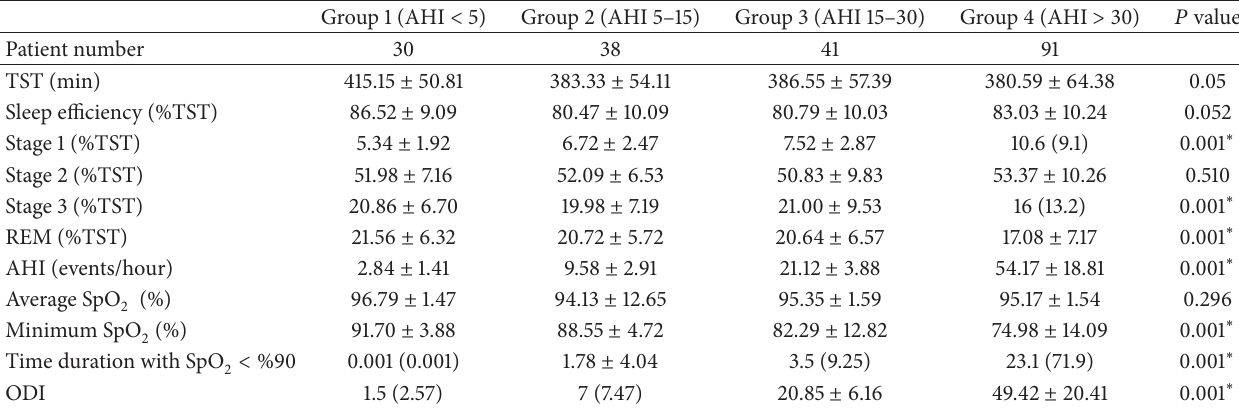
Table 2: Sleep characteristics of the patients.